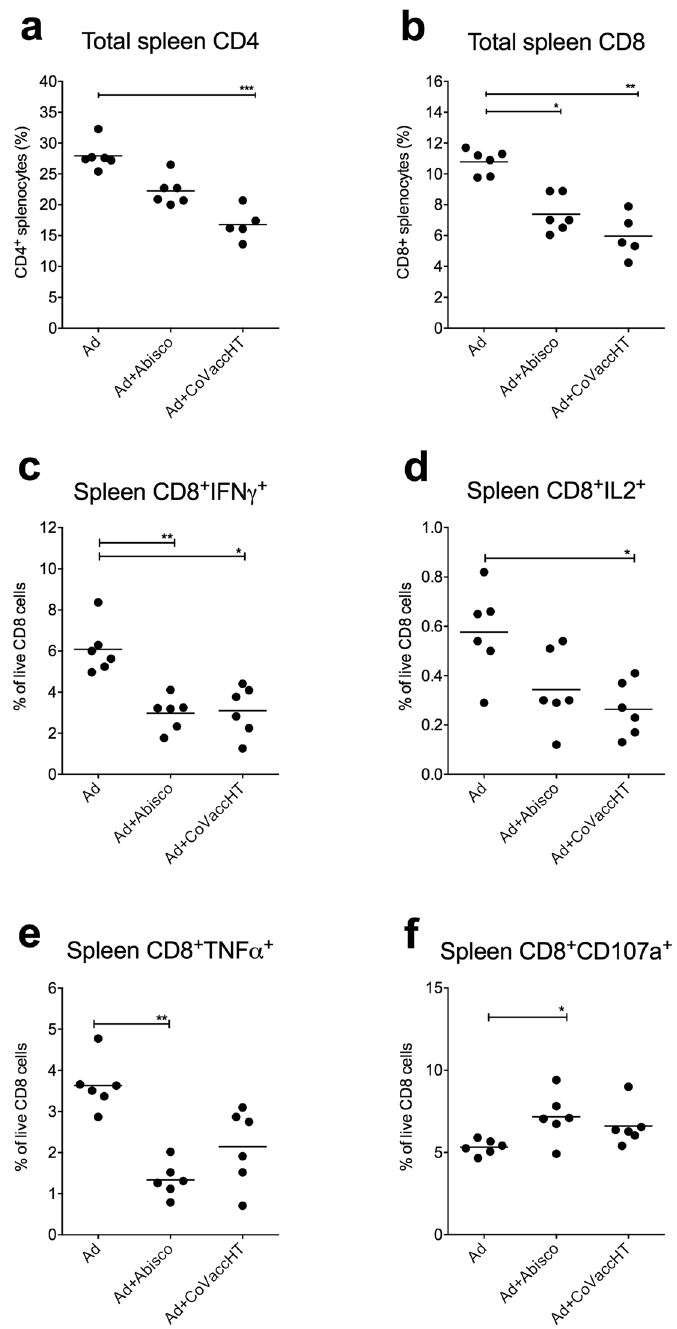
Figure 4. Splenocyte analysis in animals vaccinated with the adjuvanted and unadjuvanted Ad-ME.TRAP vaccine. Two weeks after immunisation of BALB/c mice (n = 6) with Ad-ME.TRAP (5 × 10 9 vp/dose), alone or adjuvanted with Abisco ® -100 or CoVaccineHT, relative proportion of different cell subsets in the spleen were analysed by flow cytometry. Data are shown for CD4 and CD8 T cells (panels a and b). In parallel, production of IFN γ , TNF α and IL2 and degranulation (CD107a expression) by CD8 + splenocytes, following 4 h of in vitro stimulation with Pb9 peptide, was assessed by intracellular staining and flow cytometry ( c–f ). Representative FACS dot plot data are shown in the Supplementary Figure S2b. Ranked one-way ANOVA analysis (Kruskal- Wallis) with Dunn’s test for multiple comparisons was used to assess statistical significance between groups; * p < 0.05, ** p < 0.01, *** p < 0.001. Data shown are representative of three independent